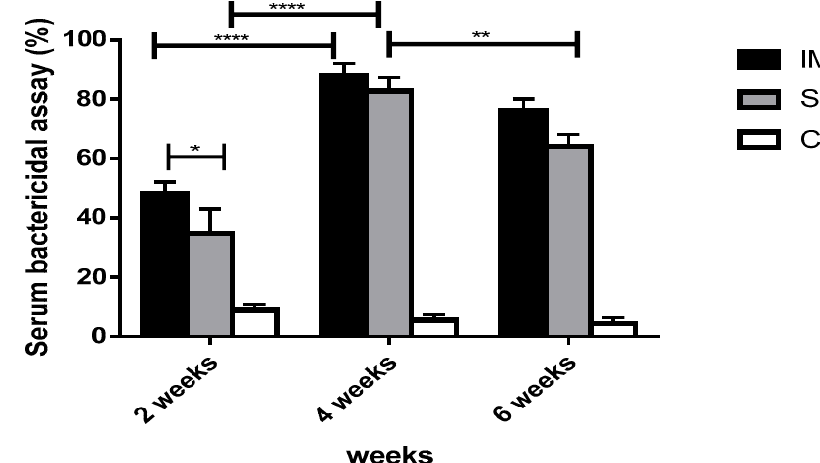
Figure 9. Serum bactericidal activity of rats vaccinated with a commercial meningococcal vaccine after 2, 4, and 6 weeks. A bar chart showing serum bactericidal activity of rats immunized with commercial vaccine through intramuscular and subcutaneous routes against PBS (control). The bactericidal activity of the serum was determined after incubation with the N. meningitidis strain for 1 h. Error bars represent the standard deviation from the mean. * Indicates significance with p < 0.05, ** indicates significance with p < 0.01, and **** indicates significance with p < 0.0001.